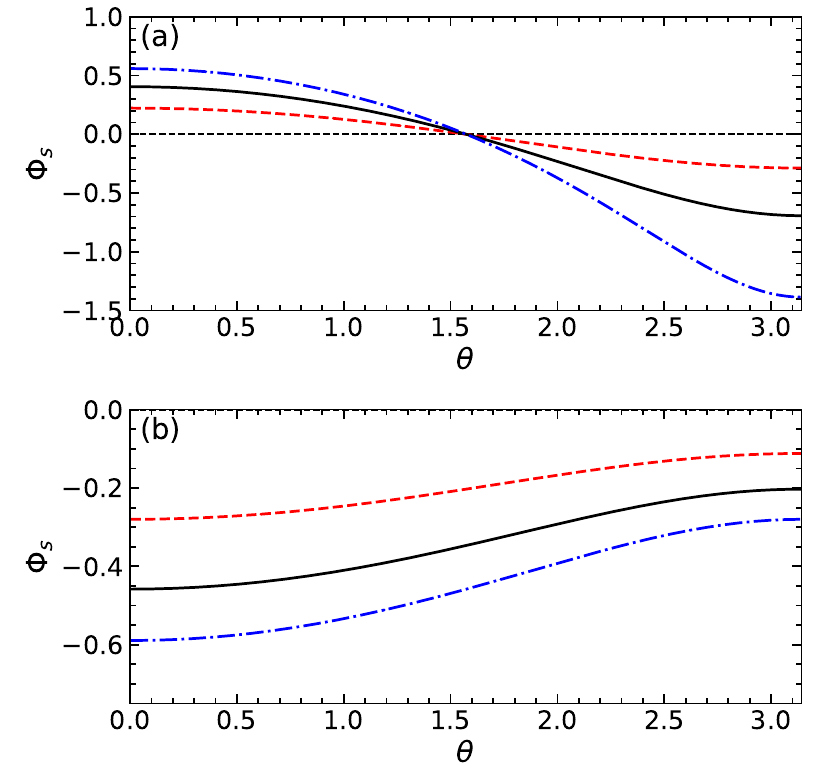
Figure 2. Φ s as a function of θ for swimmers of the first ( a ) and second ( b ) type calculated using Da = 0.5 (dashed curve), 1 (solid curve) 1.5 (dash-dotted